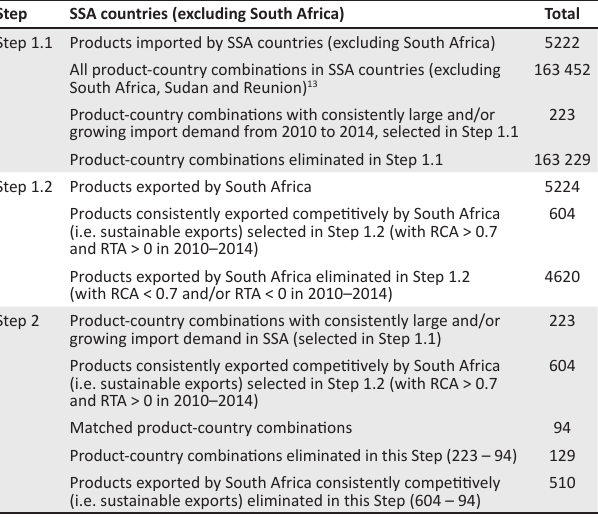
TABLE 2: Summary of results of product-country combinations obtained in Step 1.1 to Step 2. Step SSA countries (excluding South